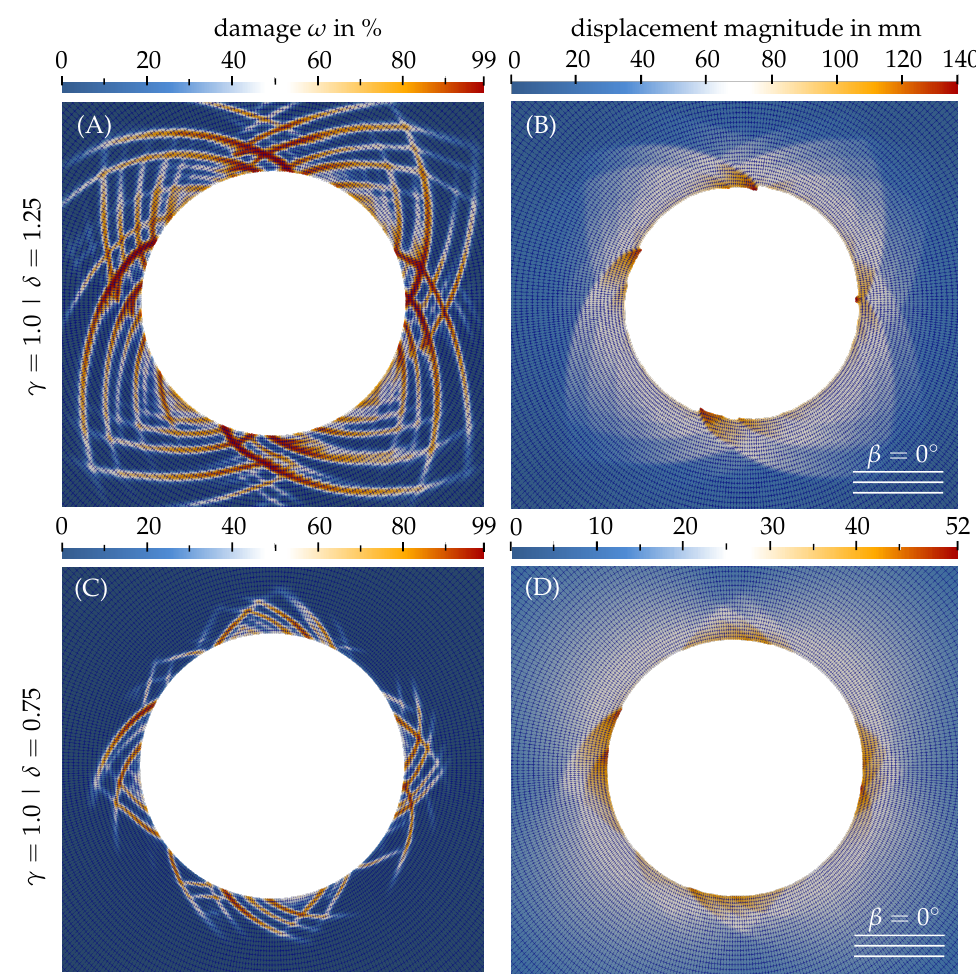
Figure 10. Distribution of the damage variable ω (left) and the displacement magnitude (right) (scale factor = 3) in the final stage of the tunnel simulation using the transversely isotropic RDP model with values of δ = 1.25 (top) and 0.75 (bottom) and a constant value γ = 1.